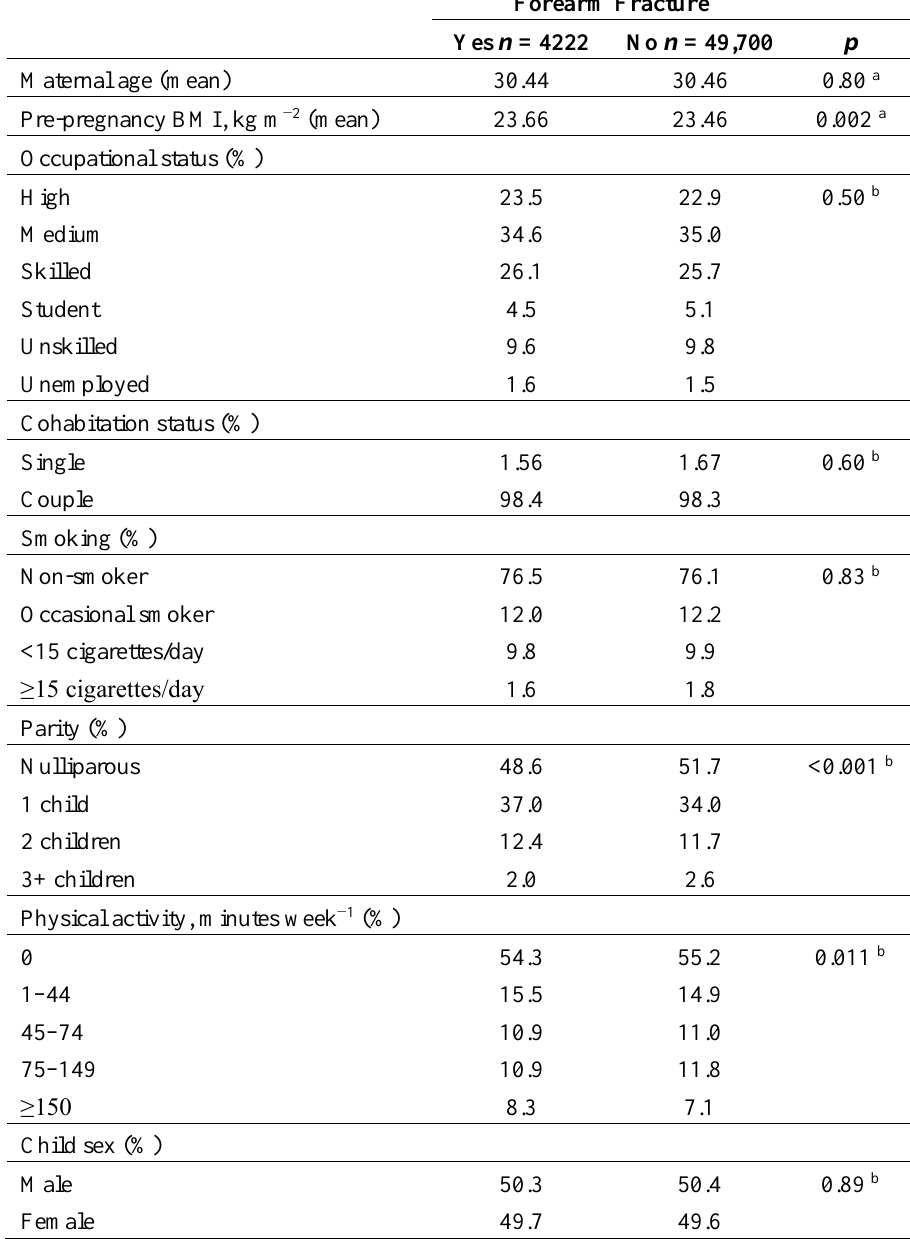
Table 2. Background characteristics of the study sample in the Danish National Birth Cohort according to fracture propensity in the offspring during childhood ( n =